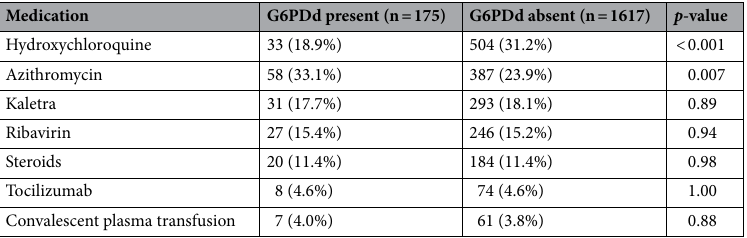
Table 3. Drug interventions during hospital stay.